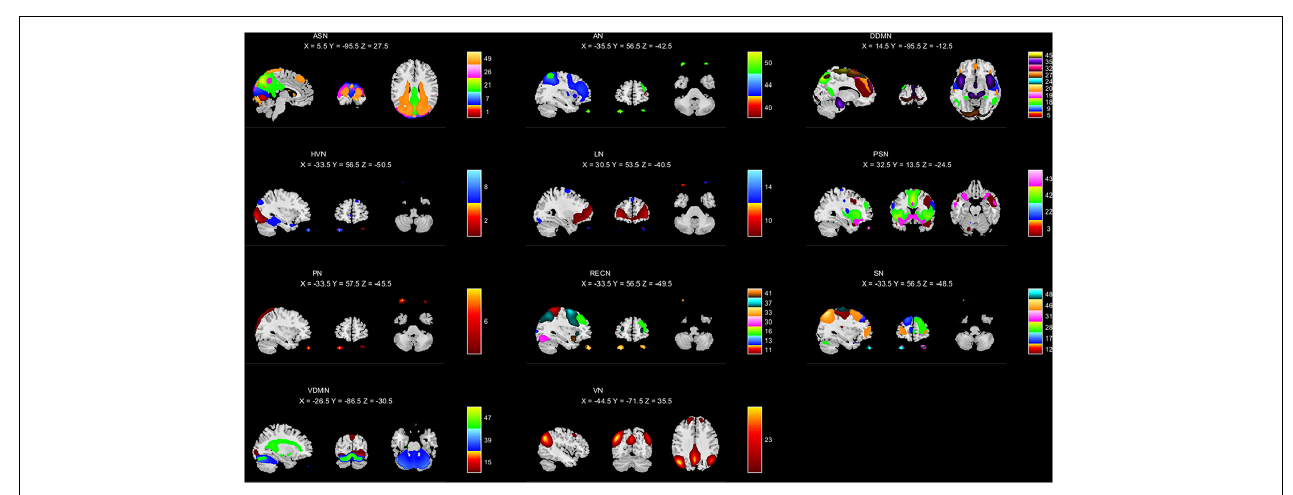
FIGURE 2 | Intrinsic connectivity networks (a total of 44) arranged into groups: ASN, AN, DDMN, HVN, LN, PSN, PN, RECN, SN, VDMN, and VN. The associated number in each group indicates the number of ICNs included the group.